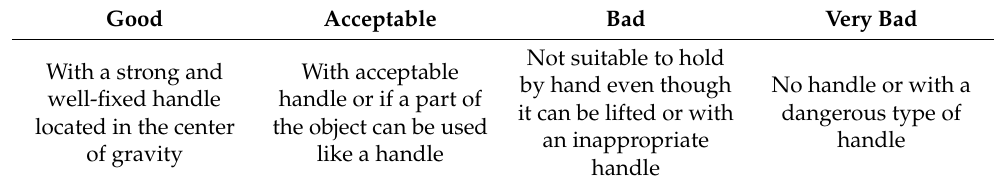
Table 13. Classification of handle